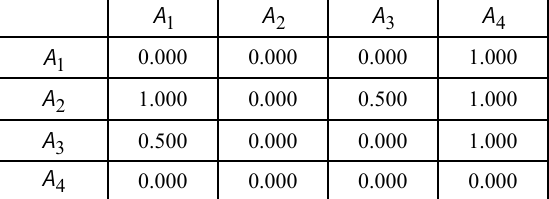
Table 9. Experts opinions represented and aggregated by the